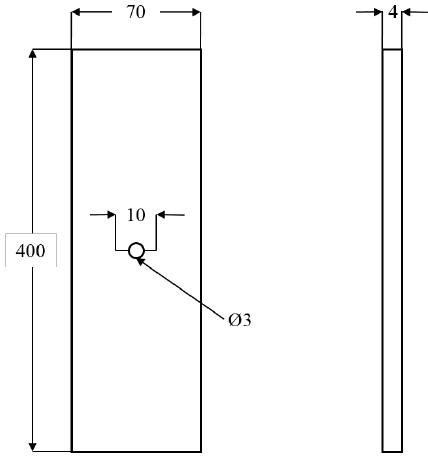
Figure 1. Geometric dimensions of single-hole test